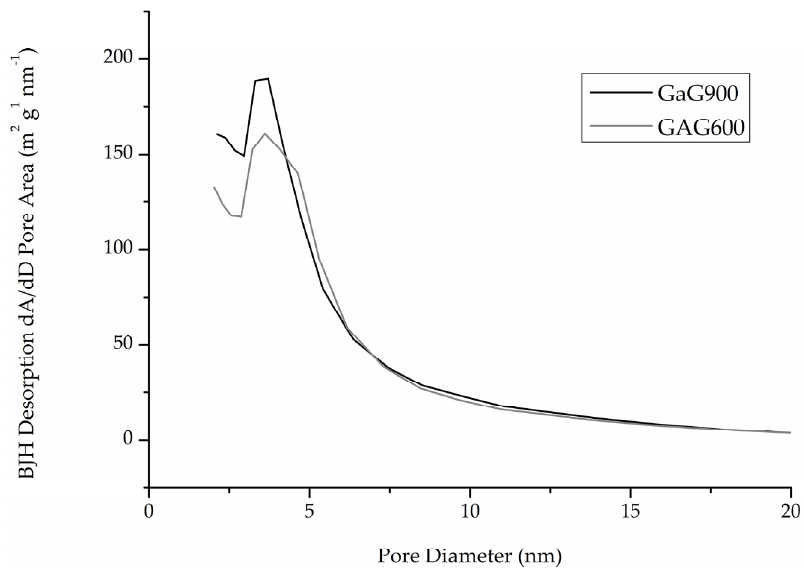
Figure 3. Porosity distribution (area ‐ desorption part of the isotherm).